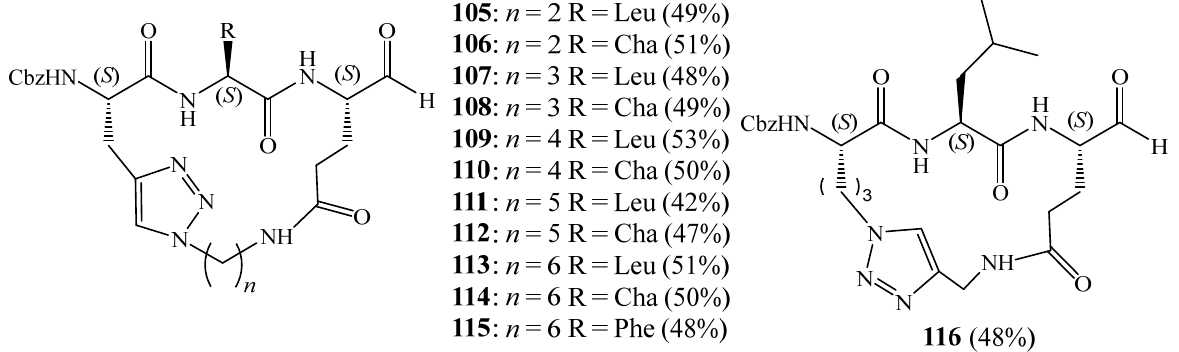
Figure 27. Structures of monatriazolic macrocycles 105 − 116 as inhibitors of norovirus 3CL protease. (Reprinted with permission from ref. [47]. Copyright 2016 Elsevier).